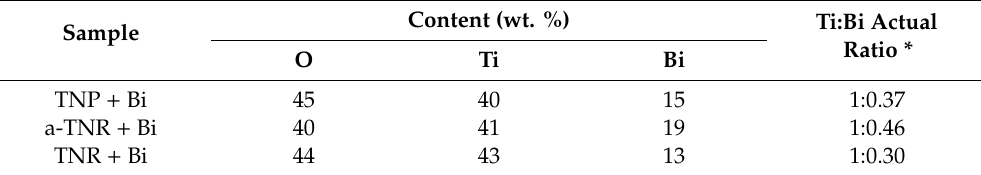
Figure 2. SEM-EDX elemental mapping conducted on prepared TiO 2 –Bi 2 O 3 composites. Table 2. Results of SEM-EDX analysis of the prepared catalysts.